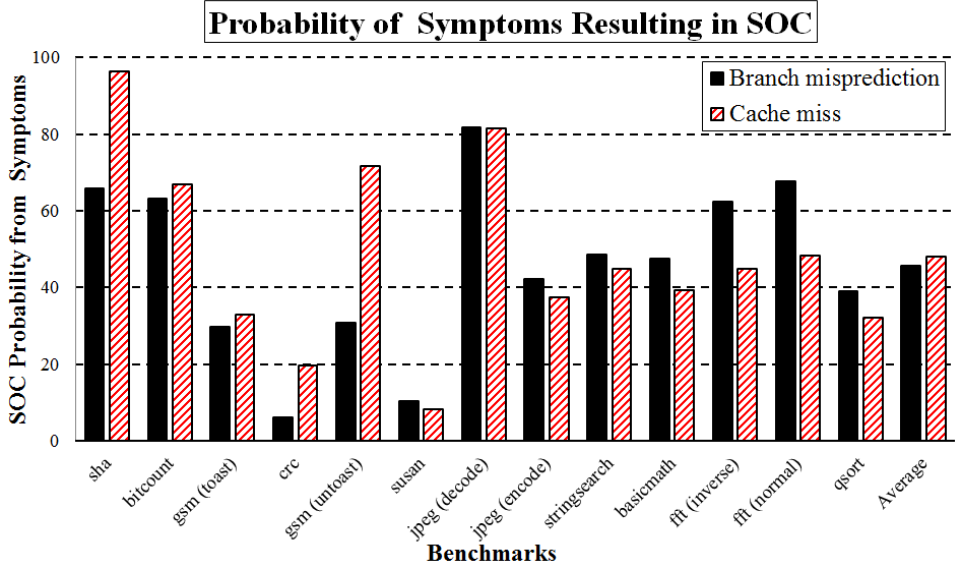
Figure 9. Probability of a fault that quickly generates a symptom resulting in SOC is less than half on average. Even symptoms do not strongly imply